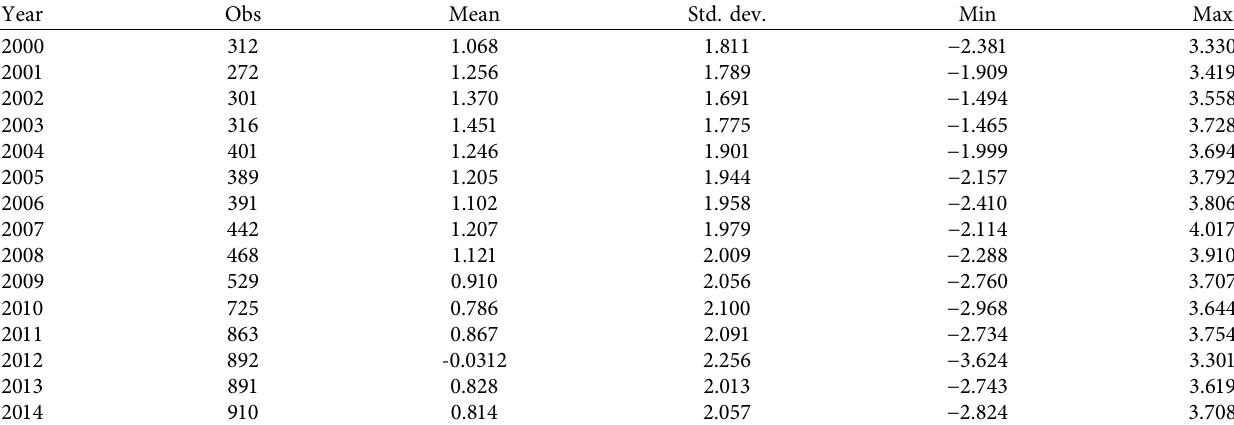
Table 1: Export product quality of listed